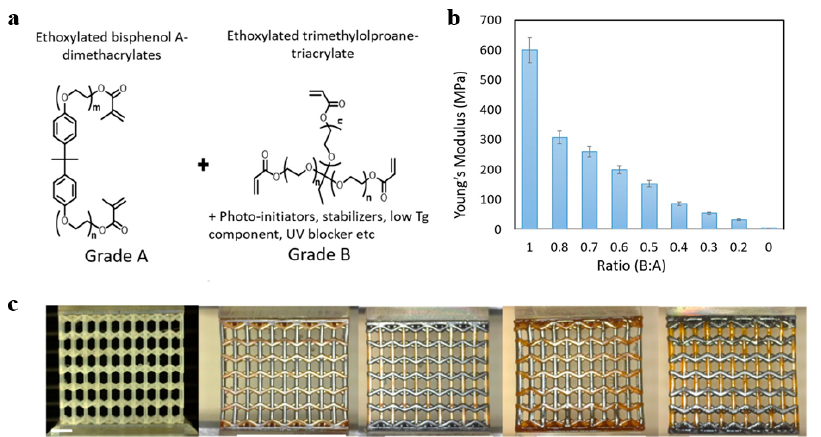
Figure 36. ( a ) Components of resin formulation; ( b ) tunable stiffness bandwidth in photocured polymers by varying concentration of A and B components; and ( c ) physical representation of printed architectures with varying compositions. Reproduced from [327].